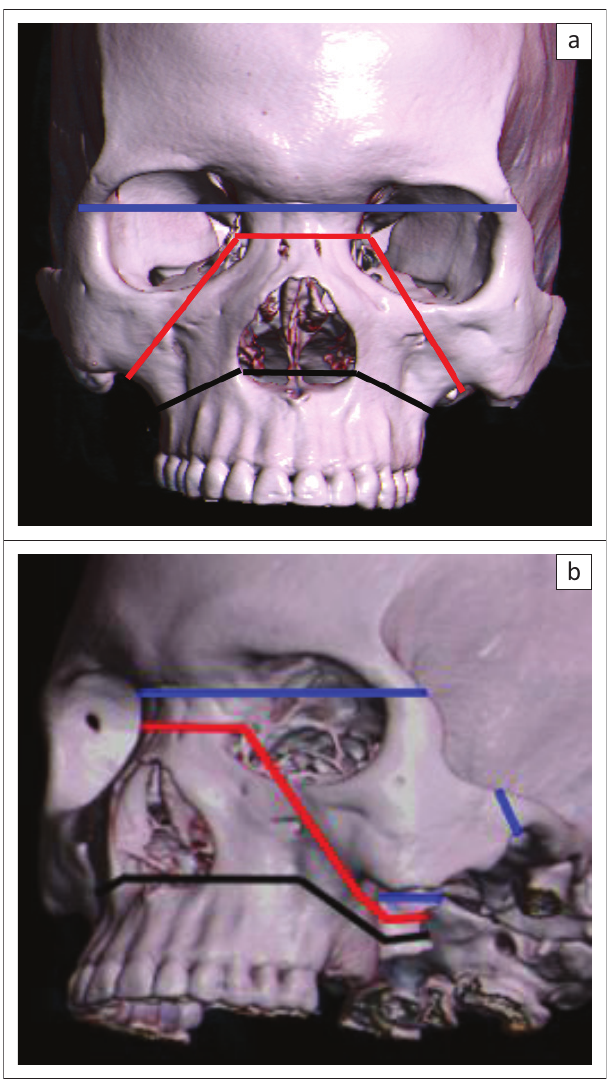
FIGURE 1: Le Fort fracture patterns: (a) AP view of a 3D reformat of a facial bone CT; and (b) left oblique view. Le Fort I (black line), Le Fort II (red line) and Le Fort III (blue line). Note how all Le Fort patterns extend posteriorly to involve the pterygoid plates in